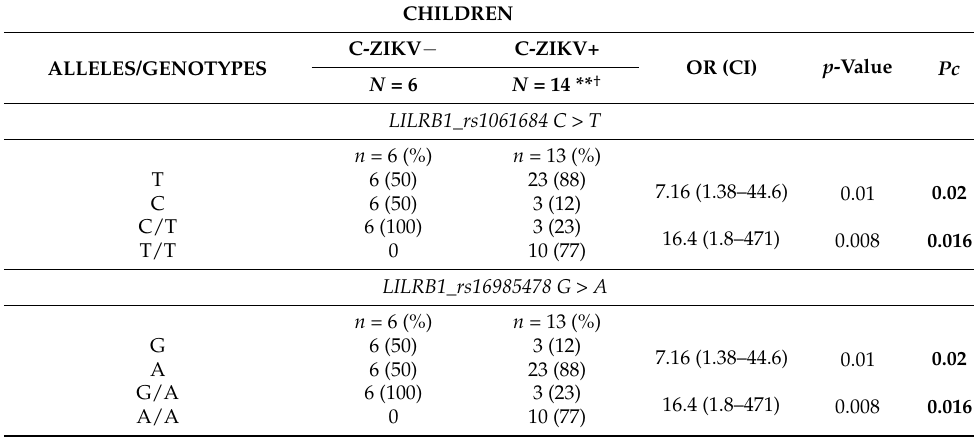
Table 2. Statistically significant allele and genotype distribution for LILRB1 and LILRB2 polymor- phisms in ZIKV-infected and non-infected children due to vertical